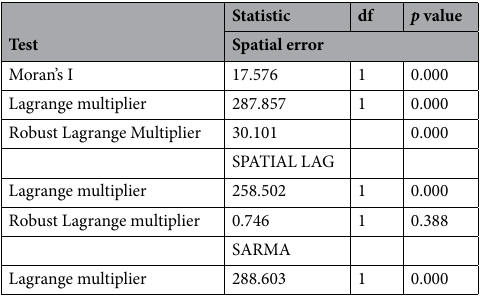
Table 4. Diagnostic tests for spatial dependence in OLS regression.